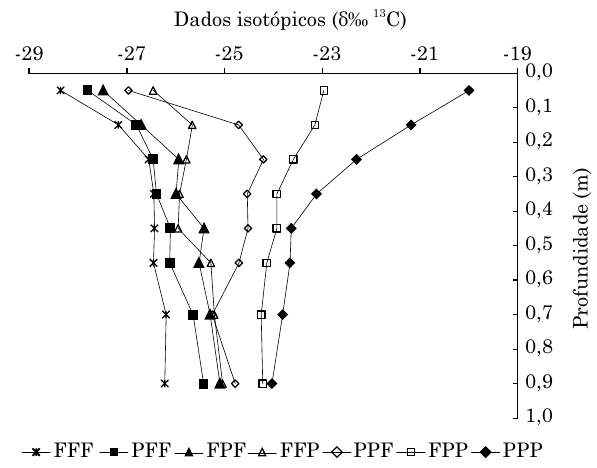
Figura 7. Abundância natural de 13 C no